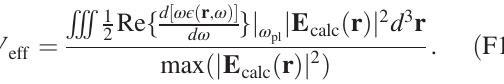
FIG. 11. HRFM mapping of the Q mode of a type-1 H 2 Pc x 2 molecule. (a) Photon-intensity, adapted with permission from Ref. [42], Springer Nature Ltd., (b) linewidth, and (c) line-shift maps of the Q line reconstructed from STML spectra acquired x 2 for each pixel of the map in Fig. 3(a) of the main text. The integration range is 1.821 – 1.837 eV. Note that, as expected, the observed spatial features are similar to the ones observed for Q x 1 in Fig. 3 of the main text but rotated by